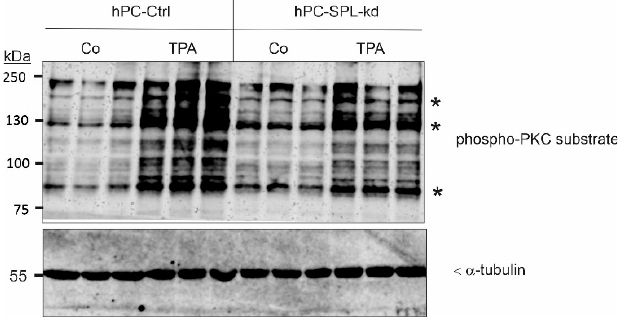
Figure 3. Effect of SPL-kd on cellular PKC activity in podocytes. Podocytes were treated for 15 min with either vehicle (DMSO, Co) or with 100 nM TPA, then taken for protein extraction and separation by SDS-PAGE, transferred to nitrocellulose, and subjected to Western blot analysis, using an anti-phospho-PKC substrate antibody (upper panel) and α -tubulin (lower panel). The data show one representative experiment in triplicate. Bands at 90 kDa, 130 kDa, and 190 kDa (indicated by *) were evaluated using the ImageJ software and are depicted in Supplementary Figure S3.